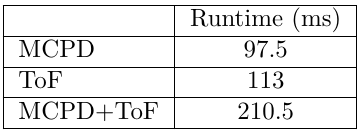
Figure 16: Error in ToF-based and MCPD-based distance measurements. Table 2: Total runtime of MCPD and ToF